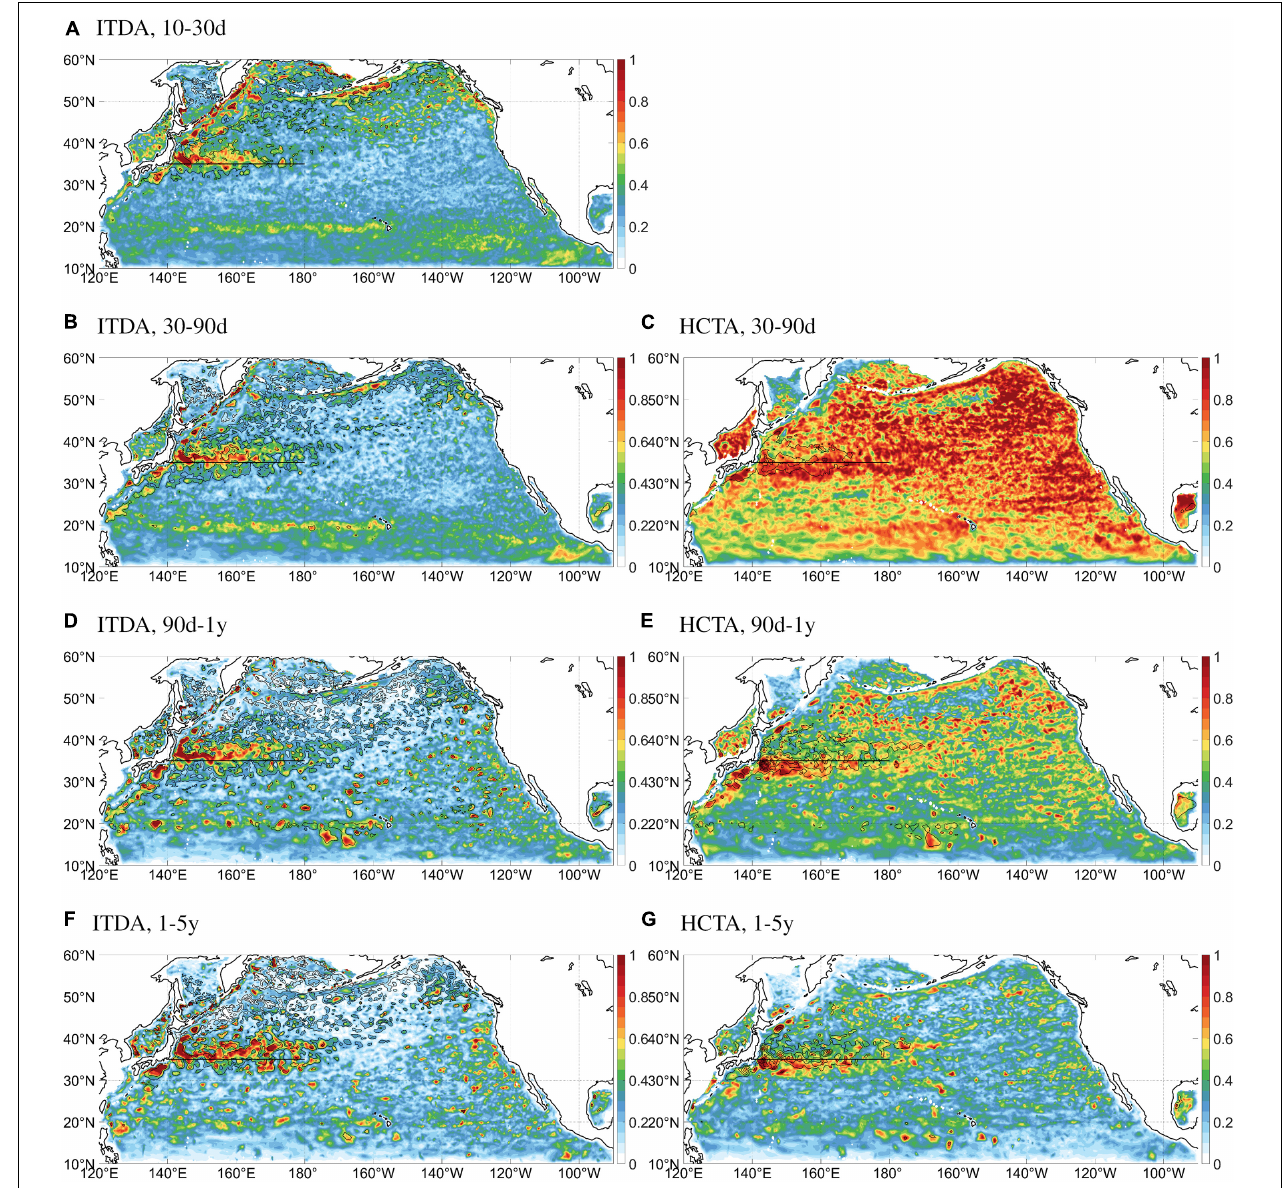
FIGURE 11 | Ratio of standard deviation of eddy-induced and original variability for (A,B,D,F) ITDA, and (C,E,G) HCTA on (A) sub-monthly (10–30 days), (B,C) intraseasonal (30–90 days), (D,E) intra-annual (90 days–1 year), and (F,G) inter-annual (1–5 year) timescales. The black line indicates the climatological position of the KE jet at 35 ◦ N. Contours show the standard deviation of the eddy-induced